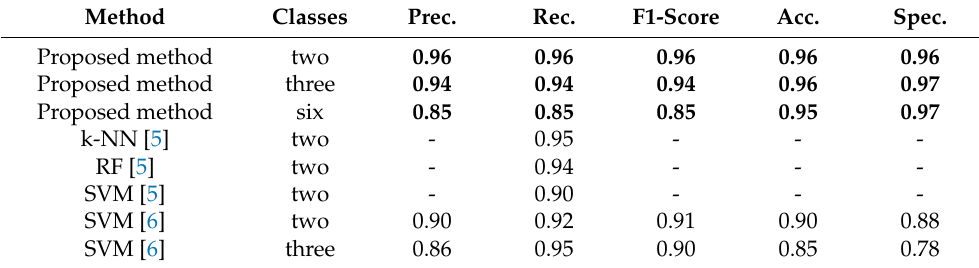
Table 8. Comparison with the methods from the literature. The best results for each metric are highlighted in